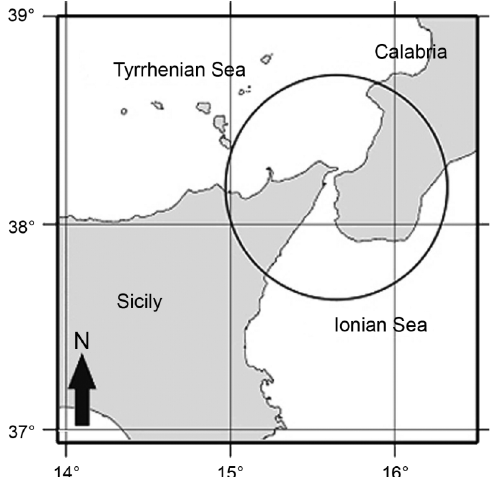
Fig. 1. The area investigated, the Straits of Messina (Southern Italy), identified by the circle in the figure.